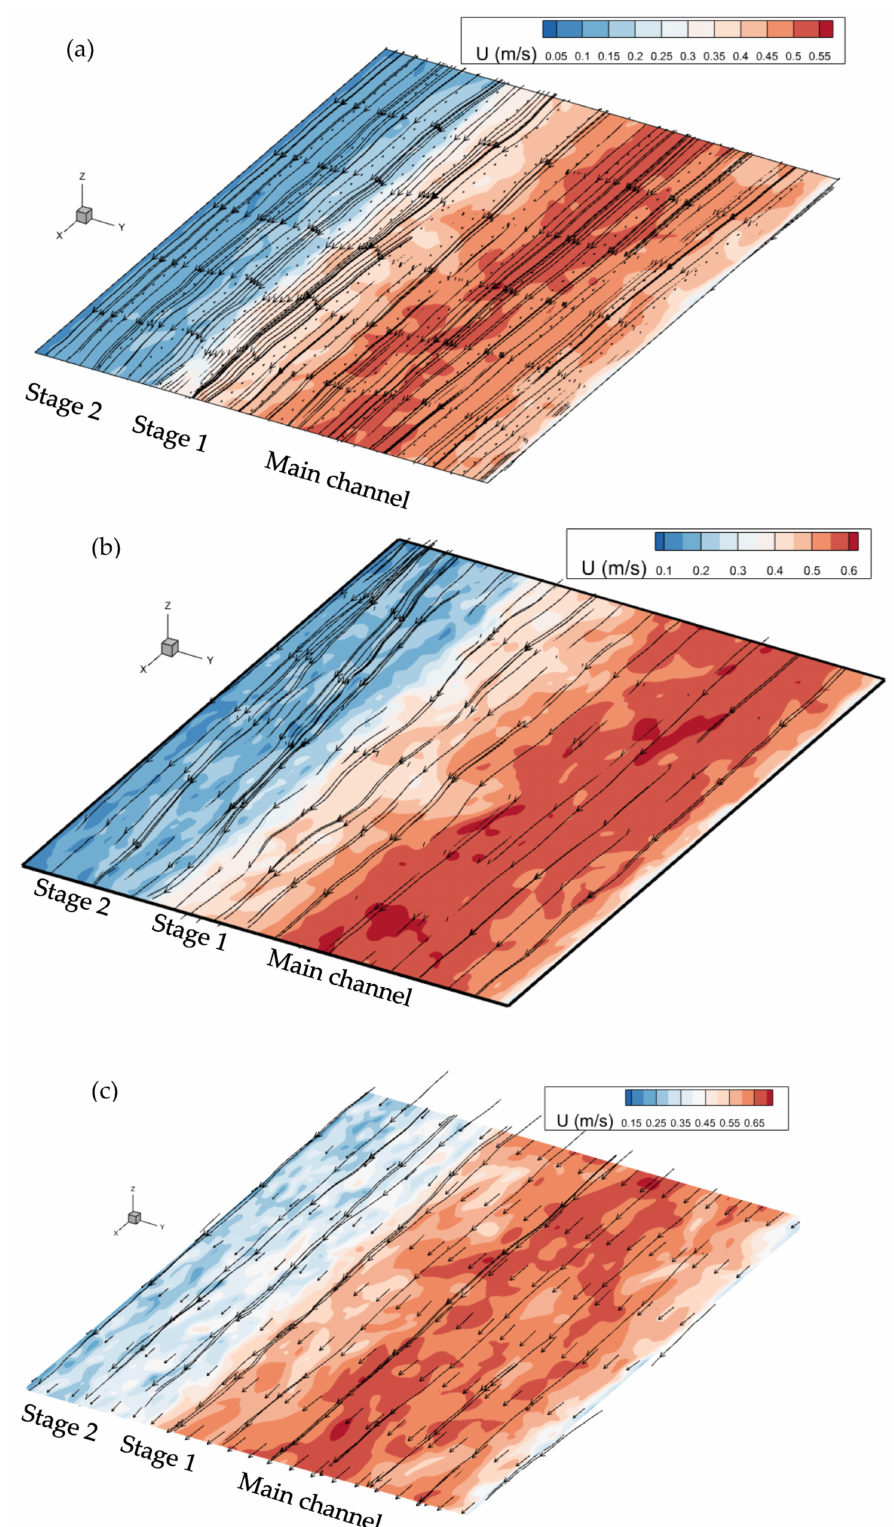
Figure 3. The distribution of the instantaneous streamwise velocity u and the velocity vectors ( u , w ) for ( a ) Dr = 0.1, ( b ) Dr = 0.3 and ( c ) Dr = 0.5 to illustrate the shear layer at a horizontal plane at second stage Z = 0.08 m, for a constant time interval of 0.1 times of flow cycle. The values of w are increased by a factor of 10 for